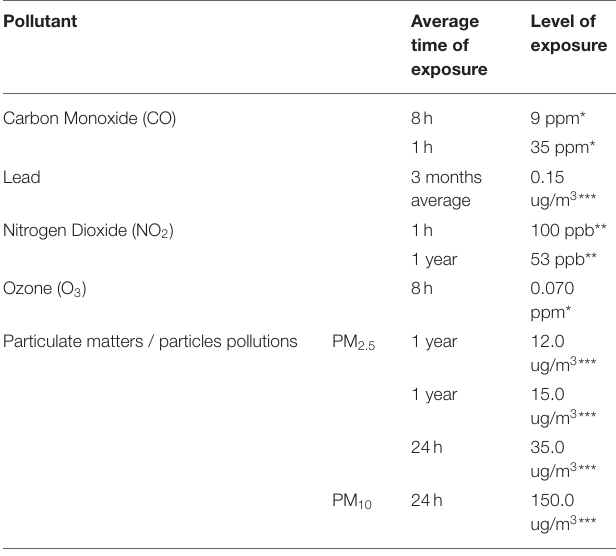
TABLE 6 | Recommendation of pollutant concentrations by National Ambient Air Quality Standards (NAAQS) by U.S. EPA (35).